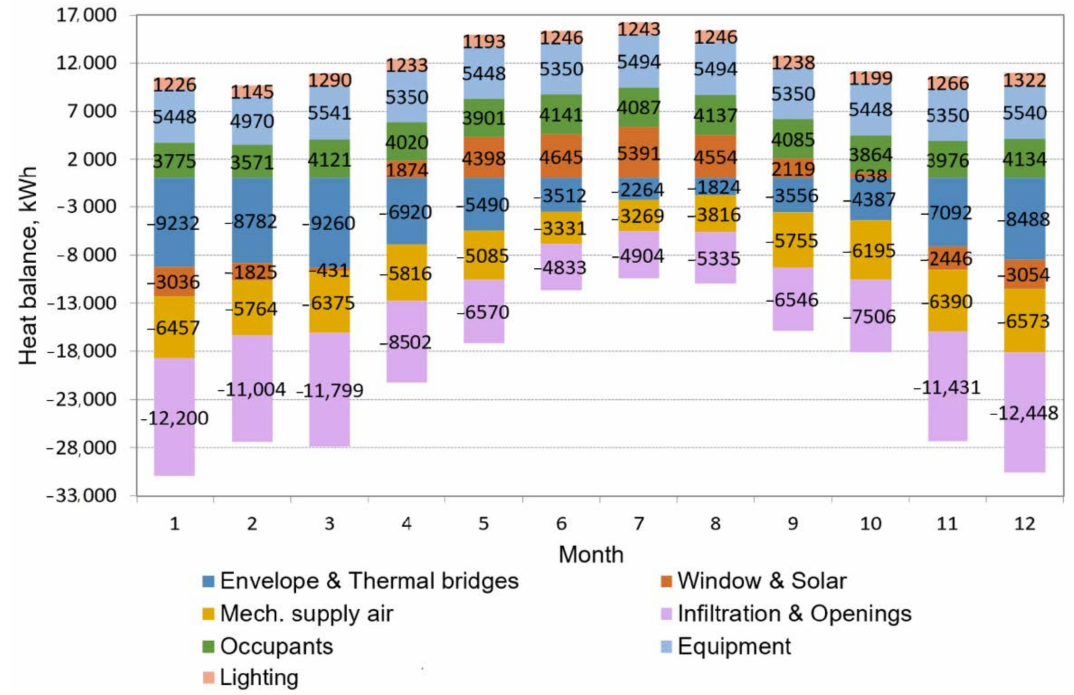
Figure 7. Monthly heat balance of the CEEE’s